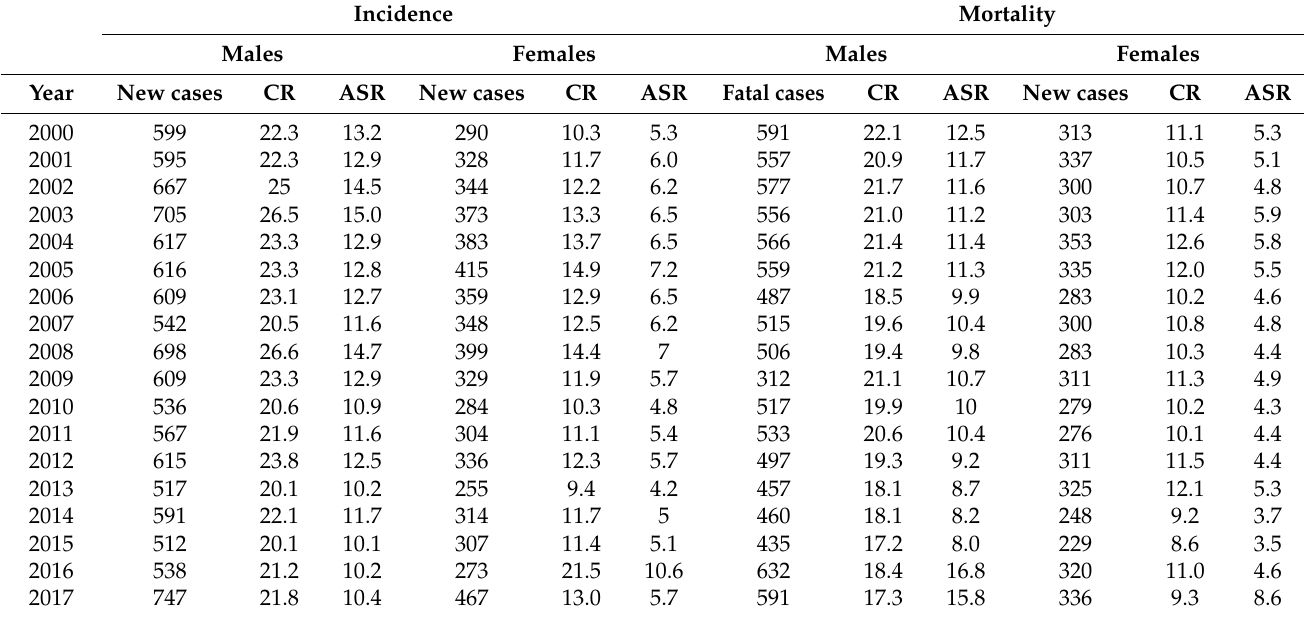
Table 2. The number of new cases, crude and age-standardized incidence and mortality rates (per 100,000 population) of stomach cancer in male and female population of Central Serbia,